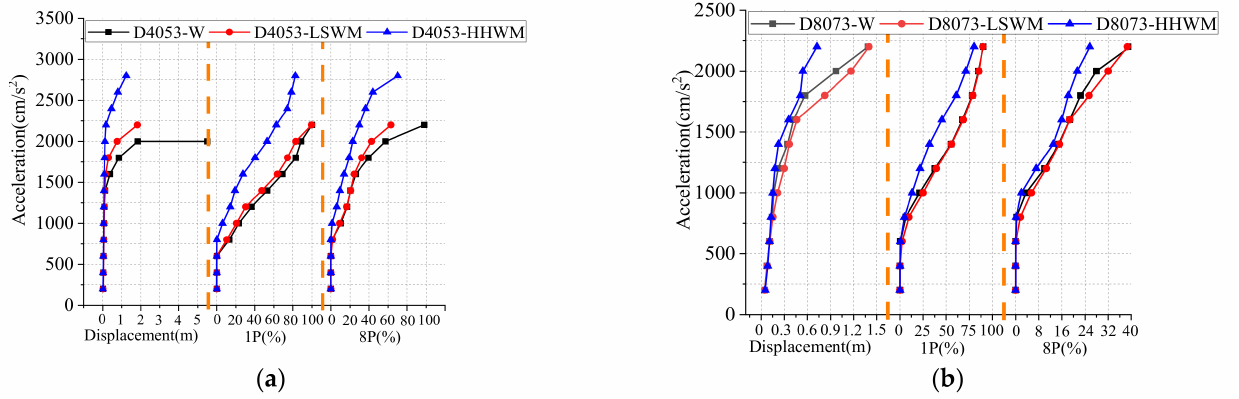
Figure 6. Maximum displacement and proportion of the plastic shell member curves: ( a ) D4053; ( b )